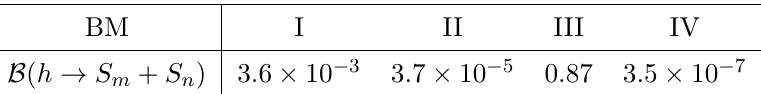
and the integral over the solid angle is 4 (cid:25) for m 6 = n and 2 (cid:25) for m = n . The invariant amplitude jMj is 2 (cid:21) ED